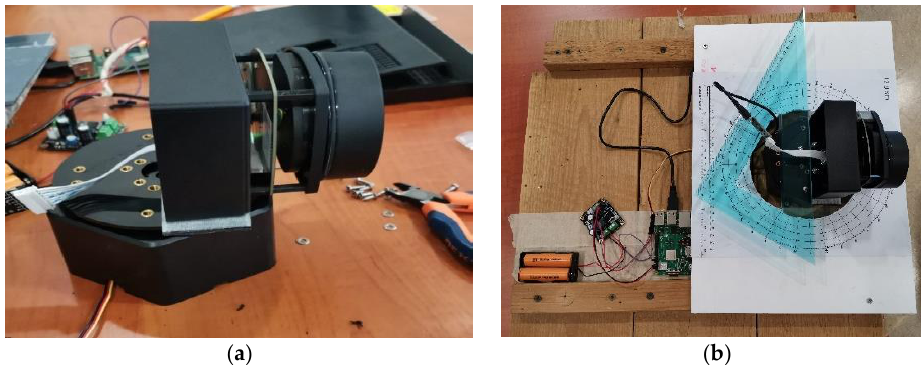
Figure 7. Electric connections of the SLAD system.